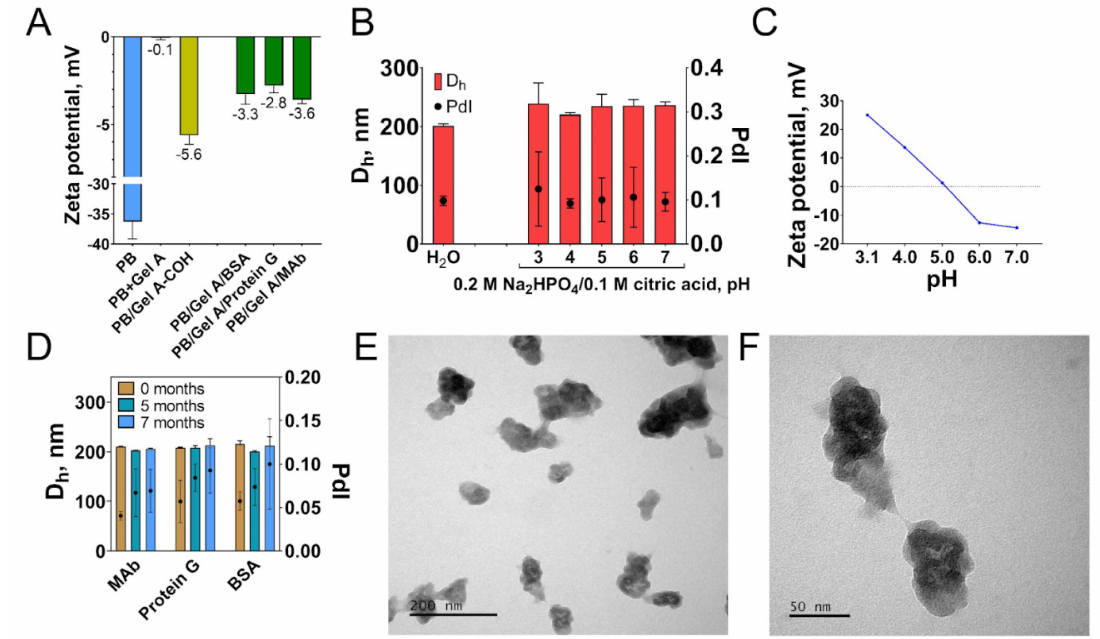
Figure 5. ( A ) Change of nanoparticle zeta potential in the course of conjugation. ( B ) Colloidal stability of PB/Gel A/Protein G in water and McIlvaine buffer with pH 3–8 (60 min incubation). ( C ) Zeta potential of PB/Gel A/Protein G in 5 mM Na 2 HPO 4 /citric acid buffer, pH 3.1–7. ( D ) Long-term colloidal stability of PB/Gel A/MAb, PB/Gel A/Protein G, and PB/Gel A/BSA in water. ( E , F ) TEM images of PB/Gel A/MAb. Scale bars: e—200 nm, f—50 nm. n = 3, mean ±